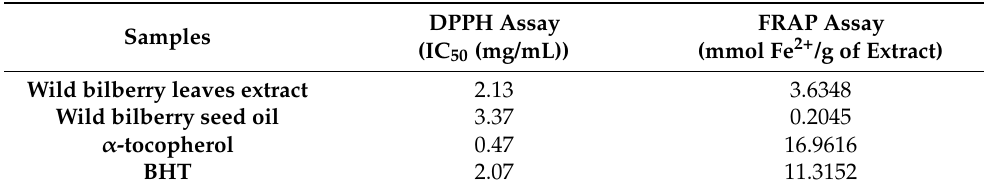
Table 5. Antioxidative activity of the investigated samples: wild bilberry isolates (leaves extract and seed oil) and positive controls ( α -tocopherol and